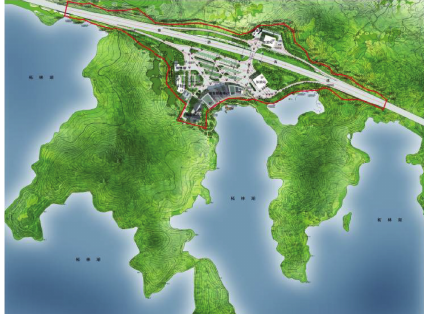
Figure 1: The aerial view of Lushan West Sea highway rest area.